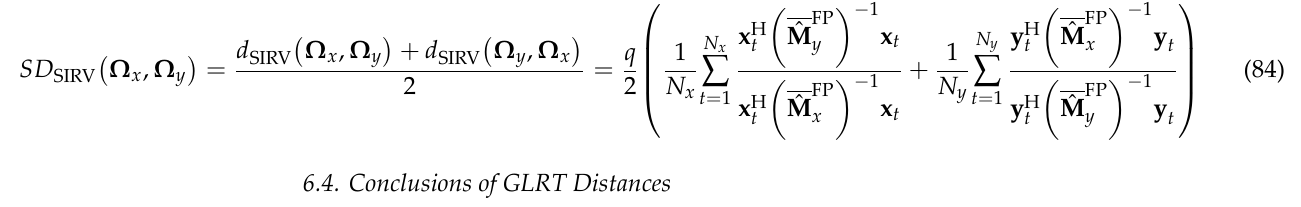
Table 4 lists some inter‑pixel GLRT distance measures for PolSAR image data. Table 4. Some inter‑pixel GLRT distance measures for PolSAR image